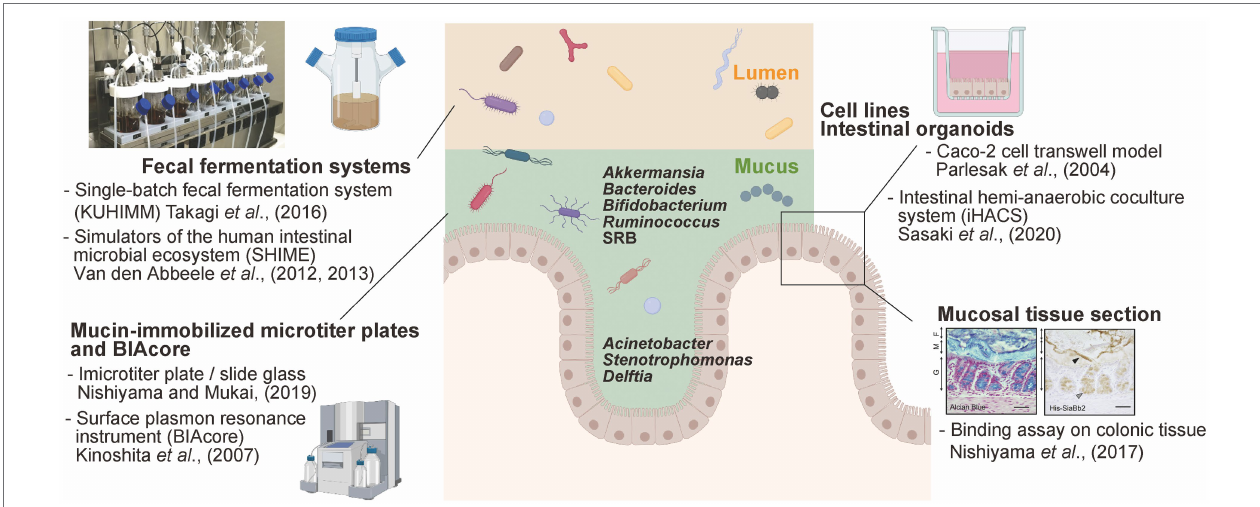
FIGURE 1 | Available experimental models to study mucus-bacteria interactions. Schematic summary of experimental models of interactions between gut bacteria and mucus secreted by enterocytes. This figure was adapted from Takagi et al. (2016) and Nishiyama et al. (2017) and created using BioRender (https://app.